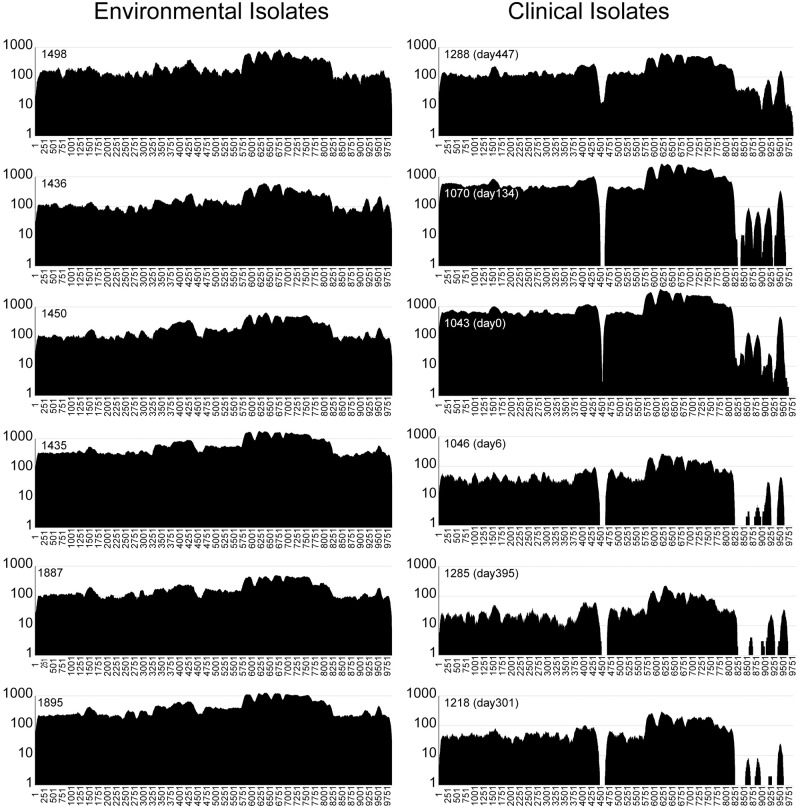
Sequence read mapping to a non-ribosomal peptide synthetase (NRPS) gene from different isolates.The Illumina reads from each of the isolates in this study were aligned to the NRPS gene from the MSHR1435 reference (MSHR1435 locus CXQ84_31440). This figure is a higher resolution representation of the read mapping shown in Fig 2 and covers the 6c and 6d regions shown there. Twelve examples of this analysis are illustrated with six environmental and six clinical isolates, with the complete isolate set present in the supplemental material (S1 Table). The read mapping shows the early loss of the internal gene sequences around position 4500 and later deletions in the 3’ region. Isolate are arranged from top to bottom in the same order as in the phylogenetic tree (Fig 3). These same isolates were all used for animal challenge experiments (see below).